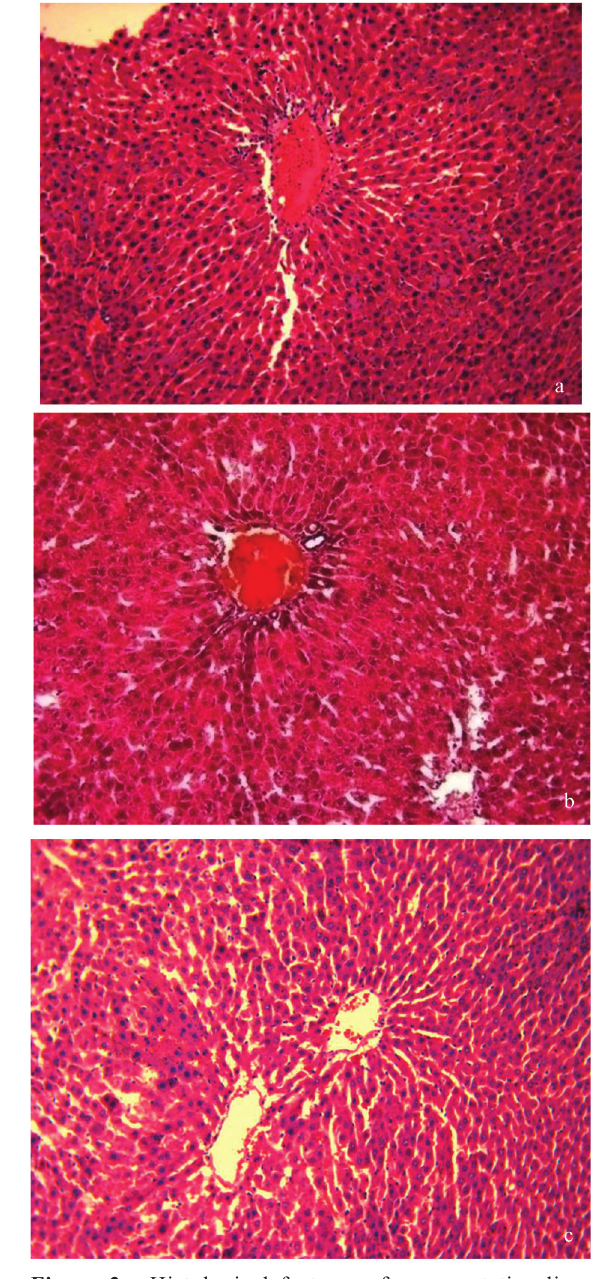
Figure 3 - Histological features of representative liver sections. a ) Group CT, control; b ) Sub-group AT-NS, treated with alcohol and co-administered with normal saline; c ） Sub- group AT-EEP, treated with alcohol and co-administered with EEP. (DEGs). Genes whose relative expression levels differed by more than 2.0-fold between two sub- groups were screened for further